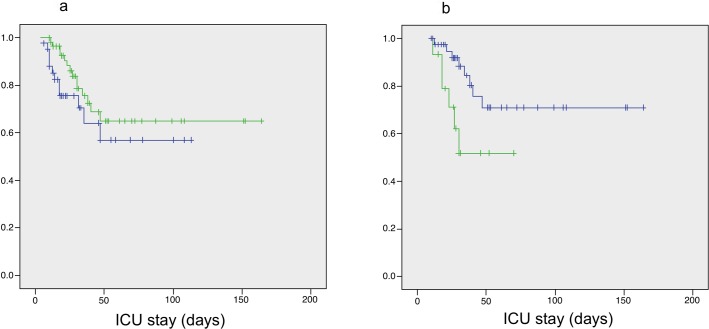
a) Survival Kaplan-Meyer analysis between Acinetobacter baumannii colonized and ventilator-associated pneumonia (VAP) patients (Blue: Colonized patients; Green: VAP patients); b) Survival Kaplan-Meyer analysis among patients with Acinetobacter baumannii ventilator-associated pneumonia, with or without bacteremia. (Blue: non-bacteremic VAP patients; Green: bacteremic VAP patients).